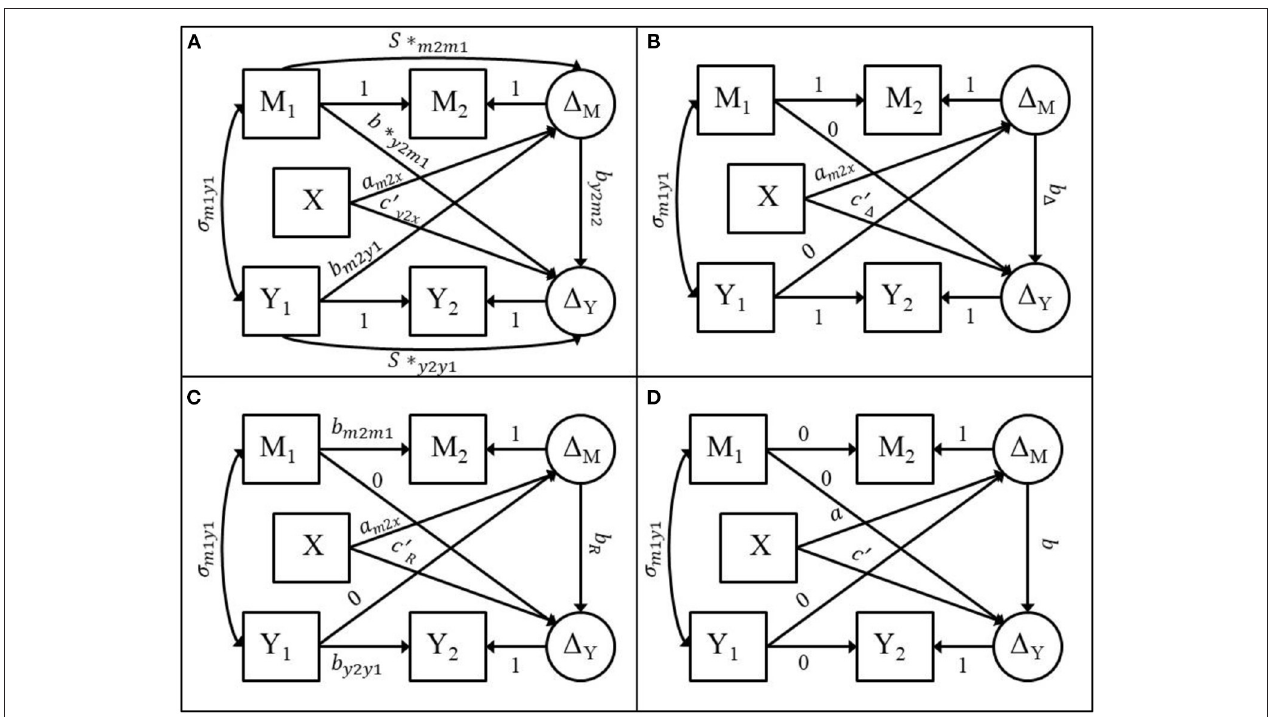
FIGURE 1 | Adapted from Valente and MacKinnon (2017). (A) LCS specification of the ANCOVA two-wave mediation model. (B) LCS specification of the difference score model. (C) LCS specification of the residualized change score model. (D) LCS specification of the cross-sectional model.